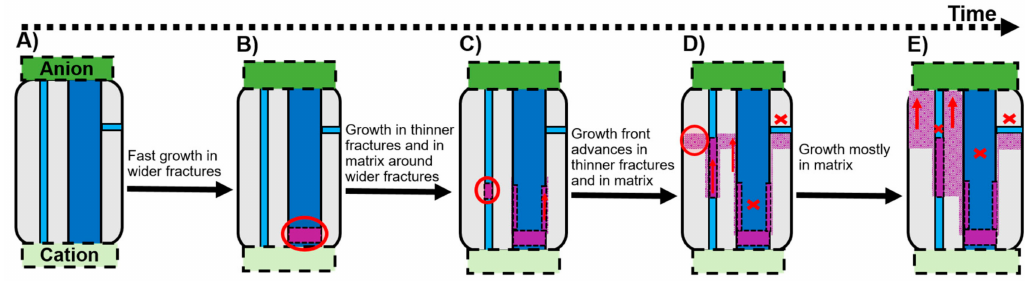
Figure 5. Scheme of di ff usion-induced mineral precipitation in nanoporous rocks (grey) containing micron (dark blue) and submicron (light blue) fractures. Zones with precipitates are shown in purple. Stages (A) to (E) exemplify the expected evolution of precipitates over time. Red circles and arrows highlight the predominant precipitation regions and directions at each stage, and the crosses highlight regions where precipitation is